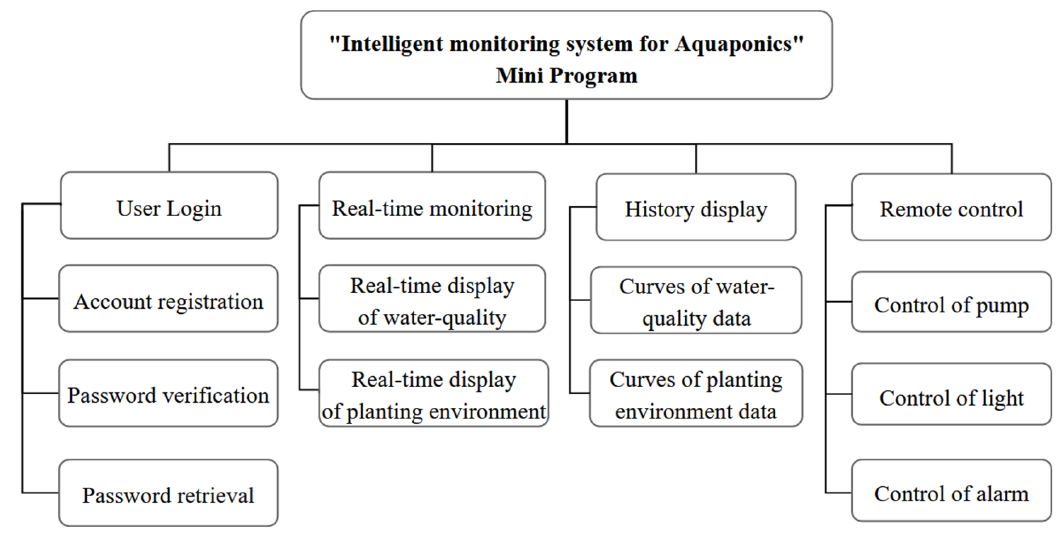
Figure 11. Block diagram of the Mini Program function.